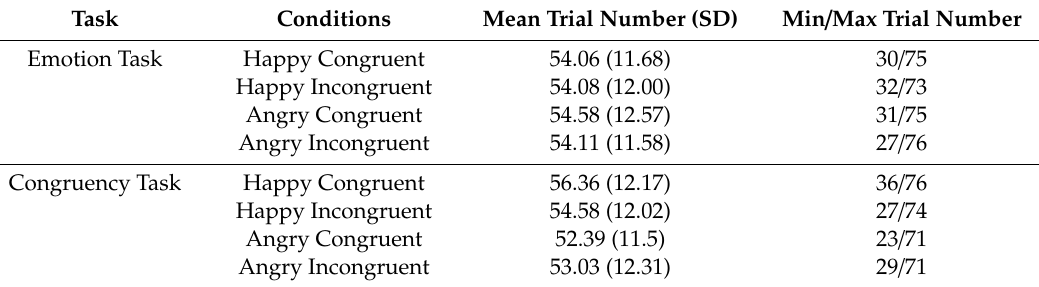
Table 1. Mean number of trial per each of the eight conditions (standard deviations in parenthesis).